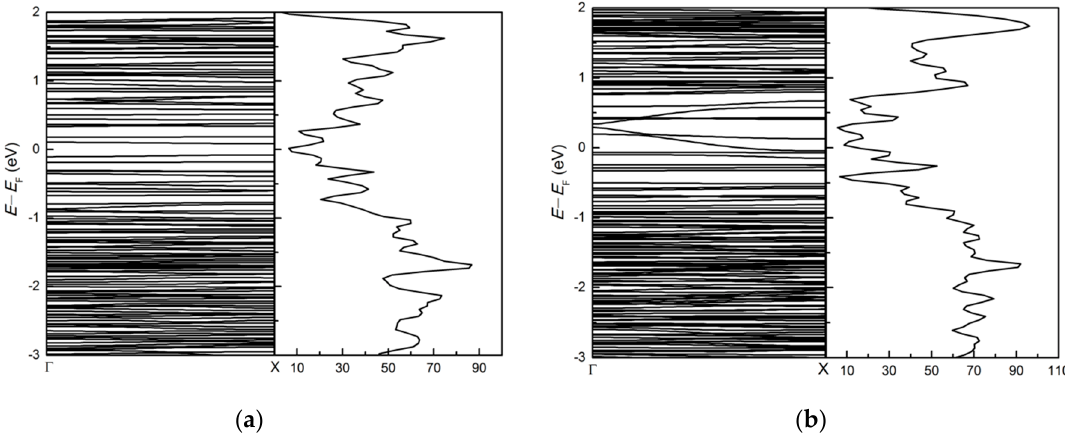
Figure 12. The band structure and dos of ( a ) symmetric and ( b ) asymmetric MoS 2( x ) Te 2(1 − x ) alloy ( x = 0.5) armchair nanorib- bons.